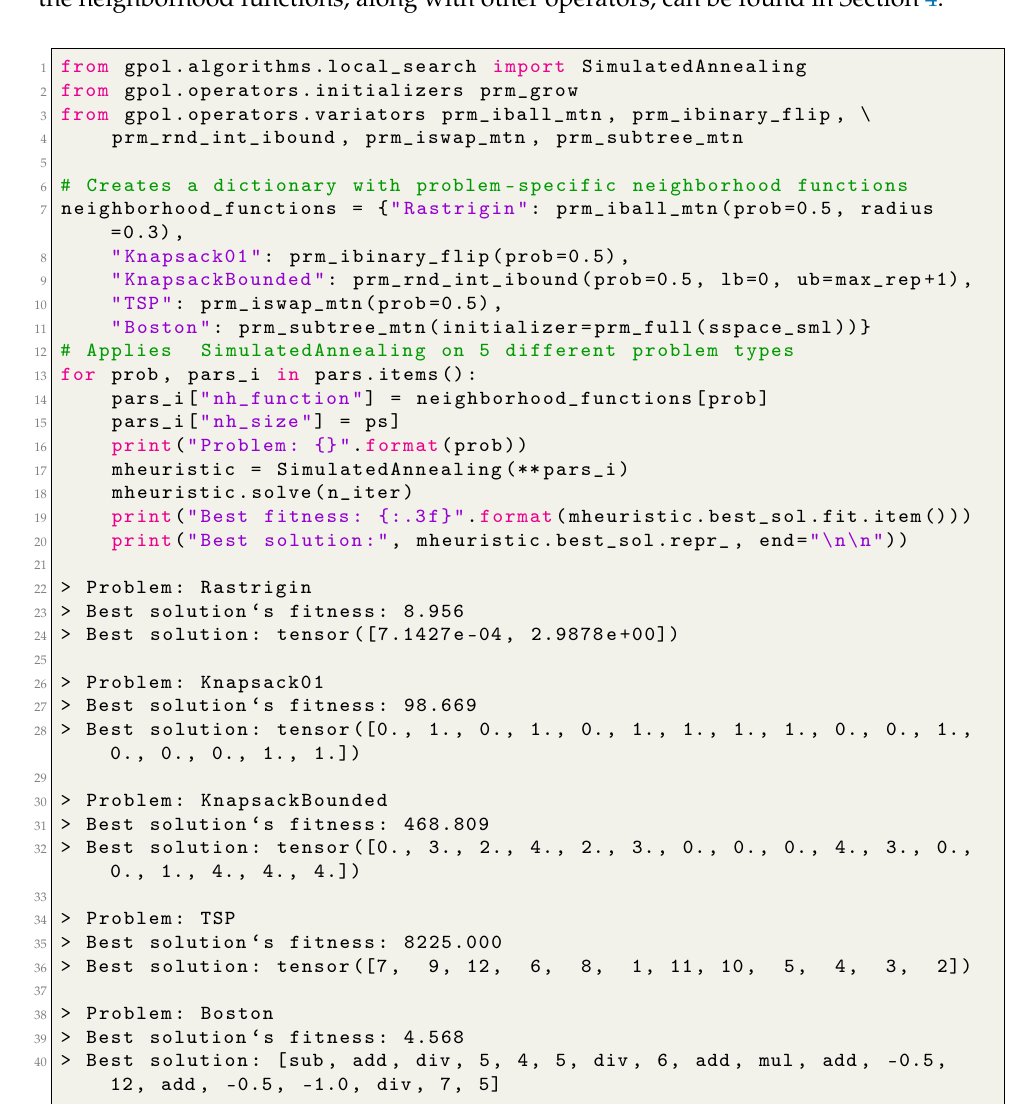
Figure A6. Examples of SimulatedAnnealing being used to solve various